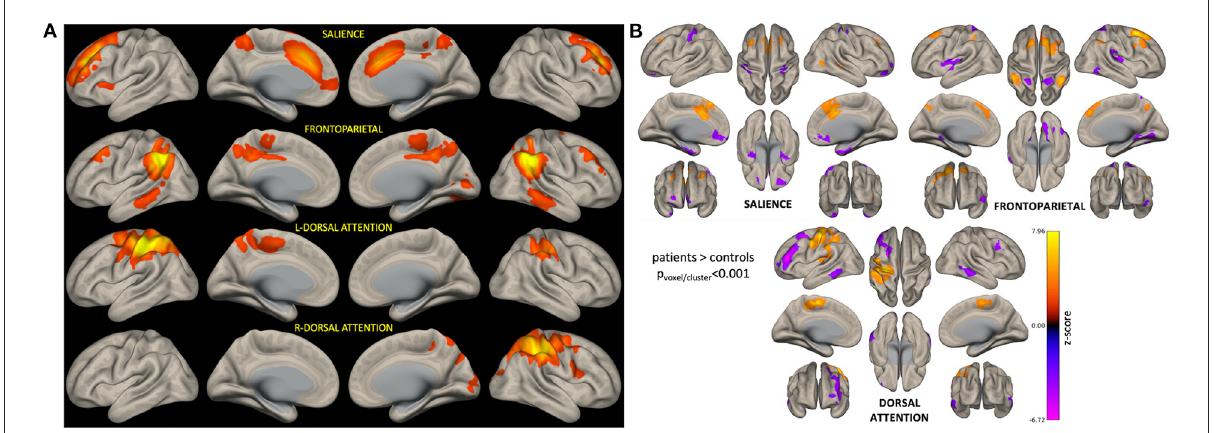
FIGURE3 ICA-derived brain networks for all subjects and seed-based analysis confirming altered networks connectivity in patients. For each patient, BOLD variability was computed as the standard deviation of network-specific timeseries data (A) . Seed-based analysis confirmed that patients had significantly altered connectivity (relative to controls) involving nodes of the networks of interest (B) . In (B) , orange corresponds to brain areas that are hyperconnected to respective network nodes in patients (relative to controls), while purple represents hypoconnected areas.